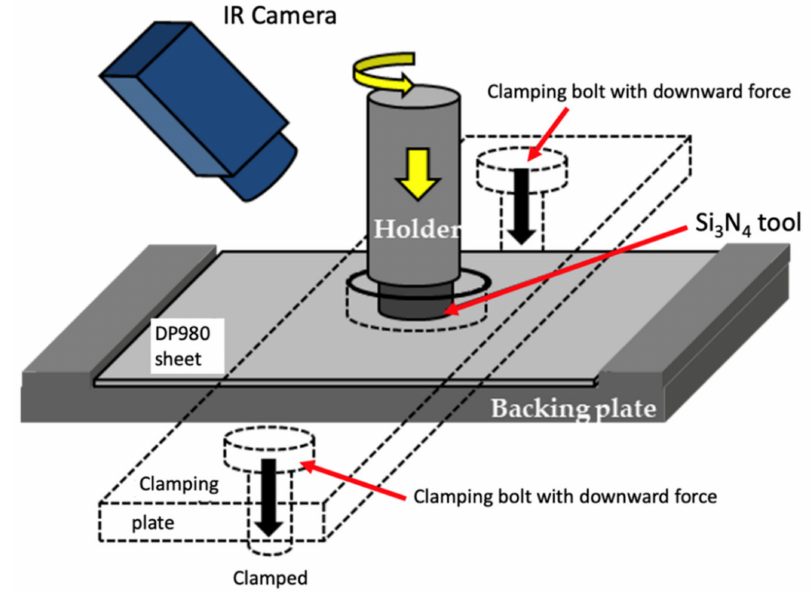
Figure 2. Schematic of friction stir spot processing (FSSP) experimental setup showing IR camera,